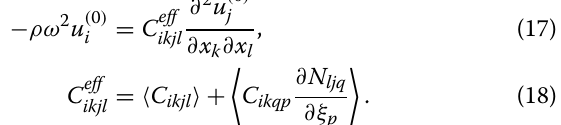
−→ k is the wave vector, and k = (cid:13)